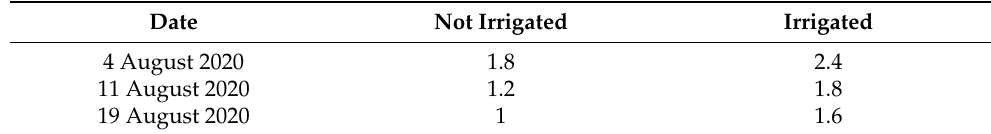
Table 4. The average measured LAI at four points (irrigated and non-irrigated; soybean) in the field. The LAI for each crop represents the average of two points that were both located on one side of the field.